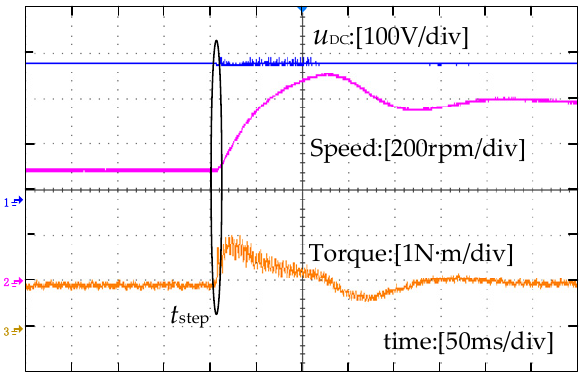
Figure 9. Dynamic experimental waveforms of a traditional motor driver with speed-up from 500 to 800 rpm.